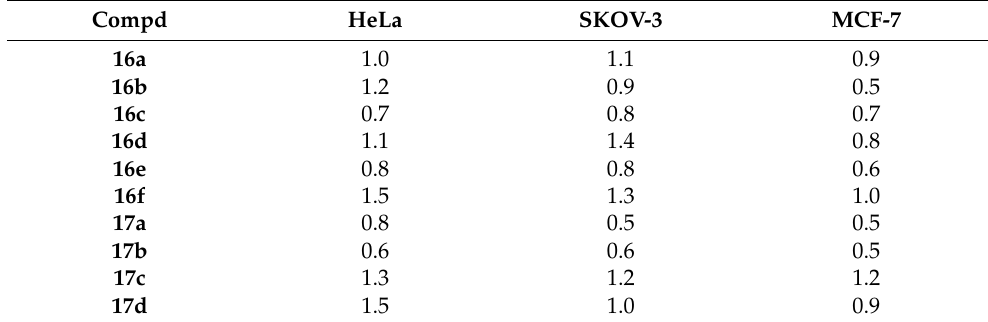
Table 5. The selectivity index values in relation to HEK-293 cells for compounds 16a – 16f and 17a – 17d